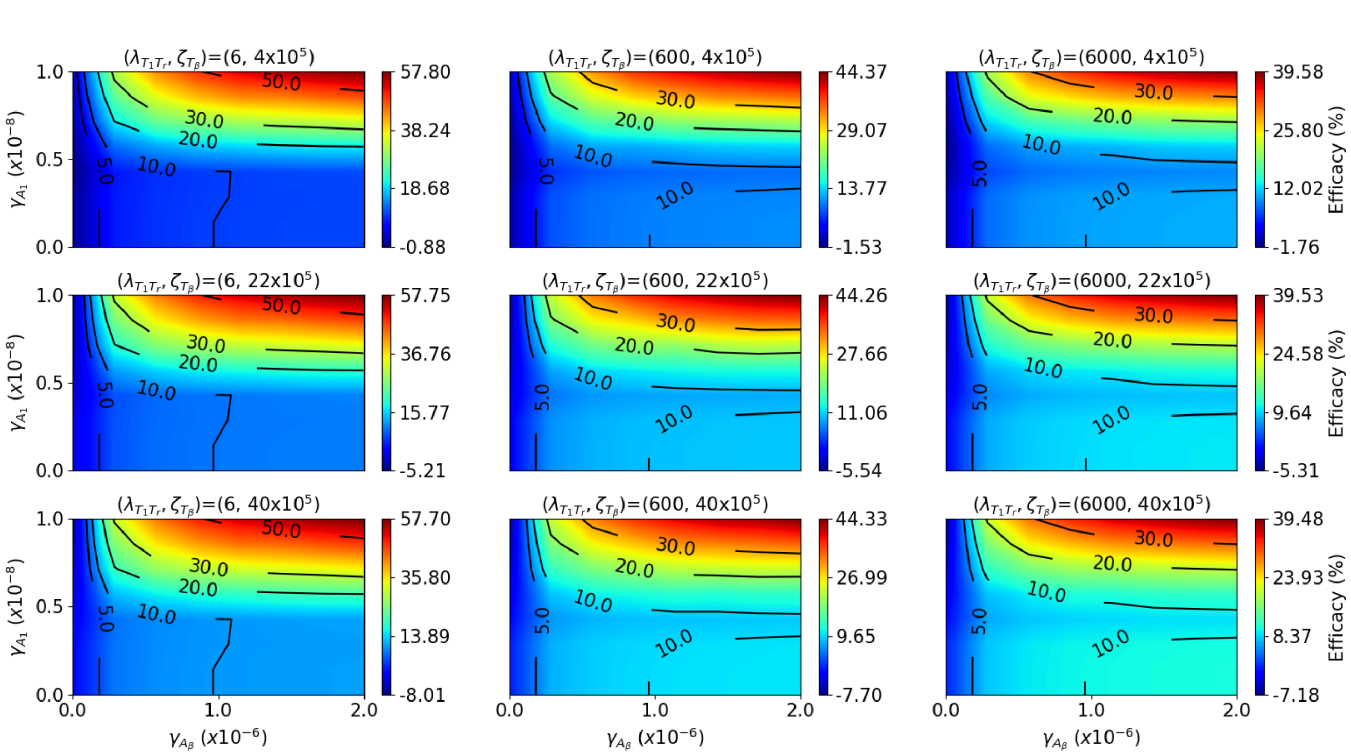
Fig 5. Efficacy map, combination of anti-PD-1 with anti-TGF- β . We vary the cancer-specific parameters l z 2 f 4 � 10 5 ; 22 � 10 5 ; 40 � 10 5 g cm 3 = g , and plot efficacy maps for the combination anti-PD-1+anti-TGF- β with doses g T b < γ β < 2 × 10 − 6 g/cm 3 � d, respectively. The color columns indicate the relative difference of the tumor at day 45. Negative values represent anti-PD-1 and anti-TGF- β dose ranges of tumor hyperprogression.